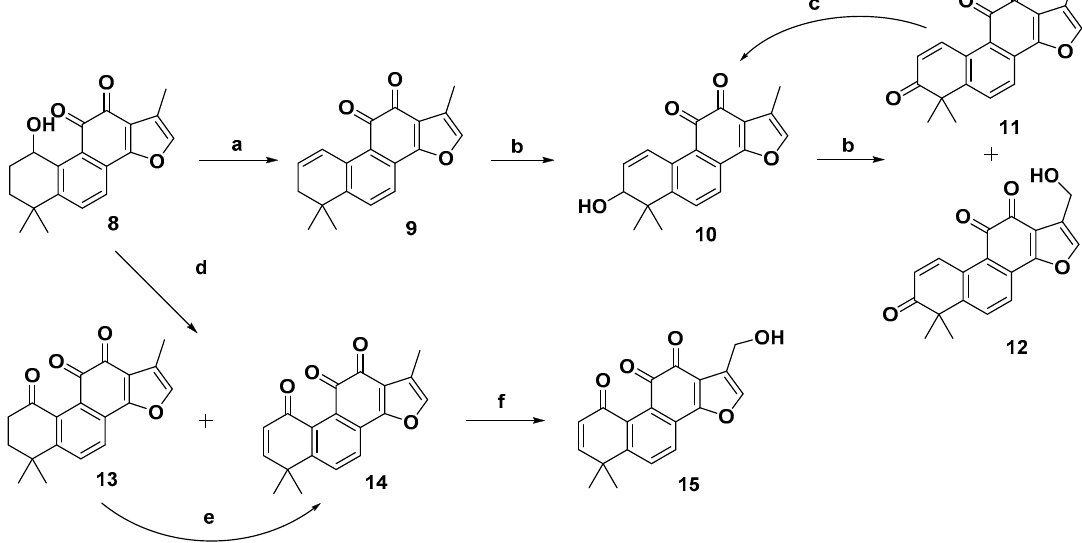
Table 2. The IDO-1 inhibitory activity of o -naphthaquinone derivatives in enzyme- and cell-based